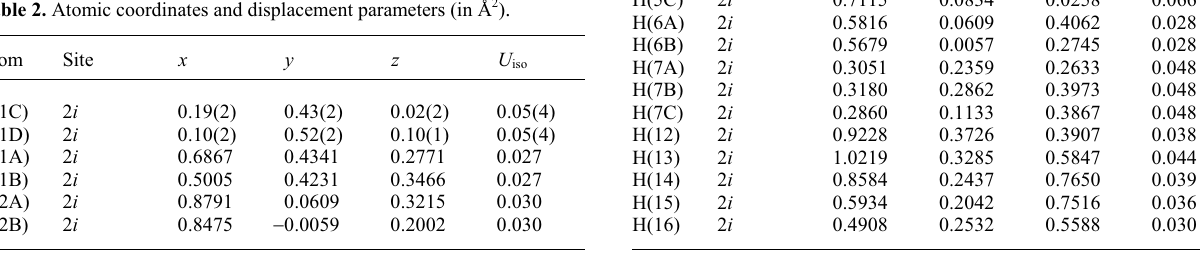
Table 3. Atomic coordinates and displacement parameters (in Å 2 )